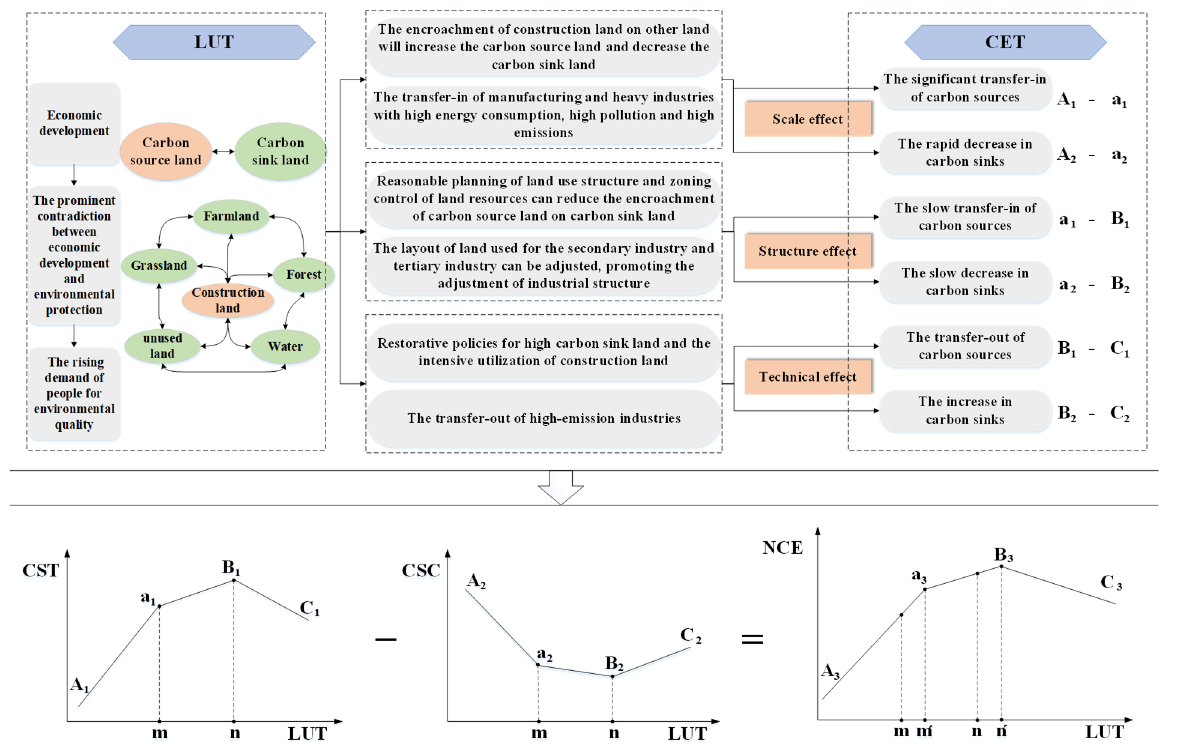
Figure 2. Theoretical analysis of the relationship between LUT and CET (CSC: carbon sink changes; CST: carbon source transfer; NCE: net carbon emissions).